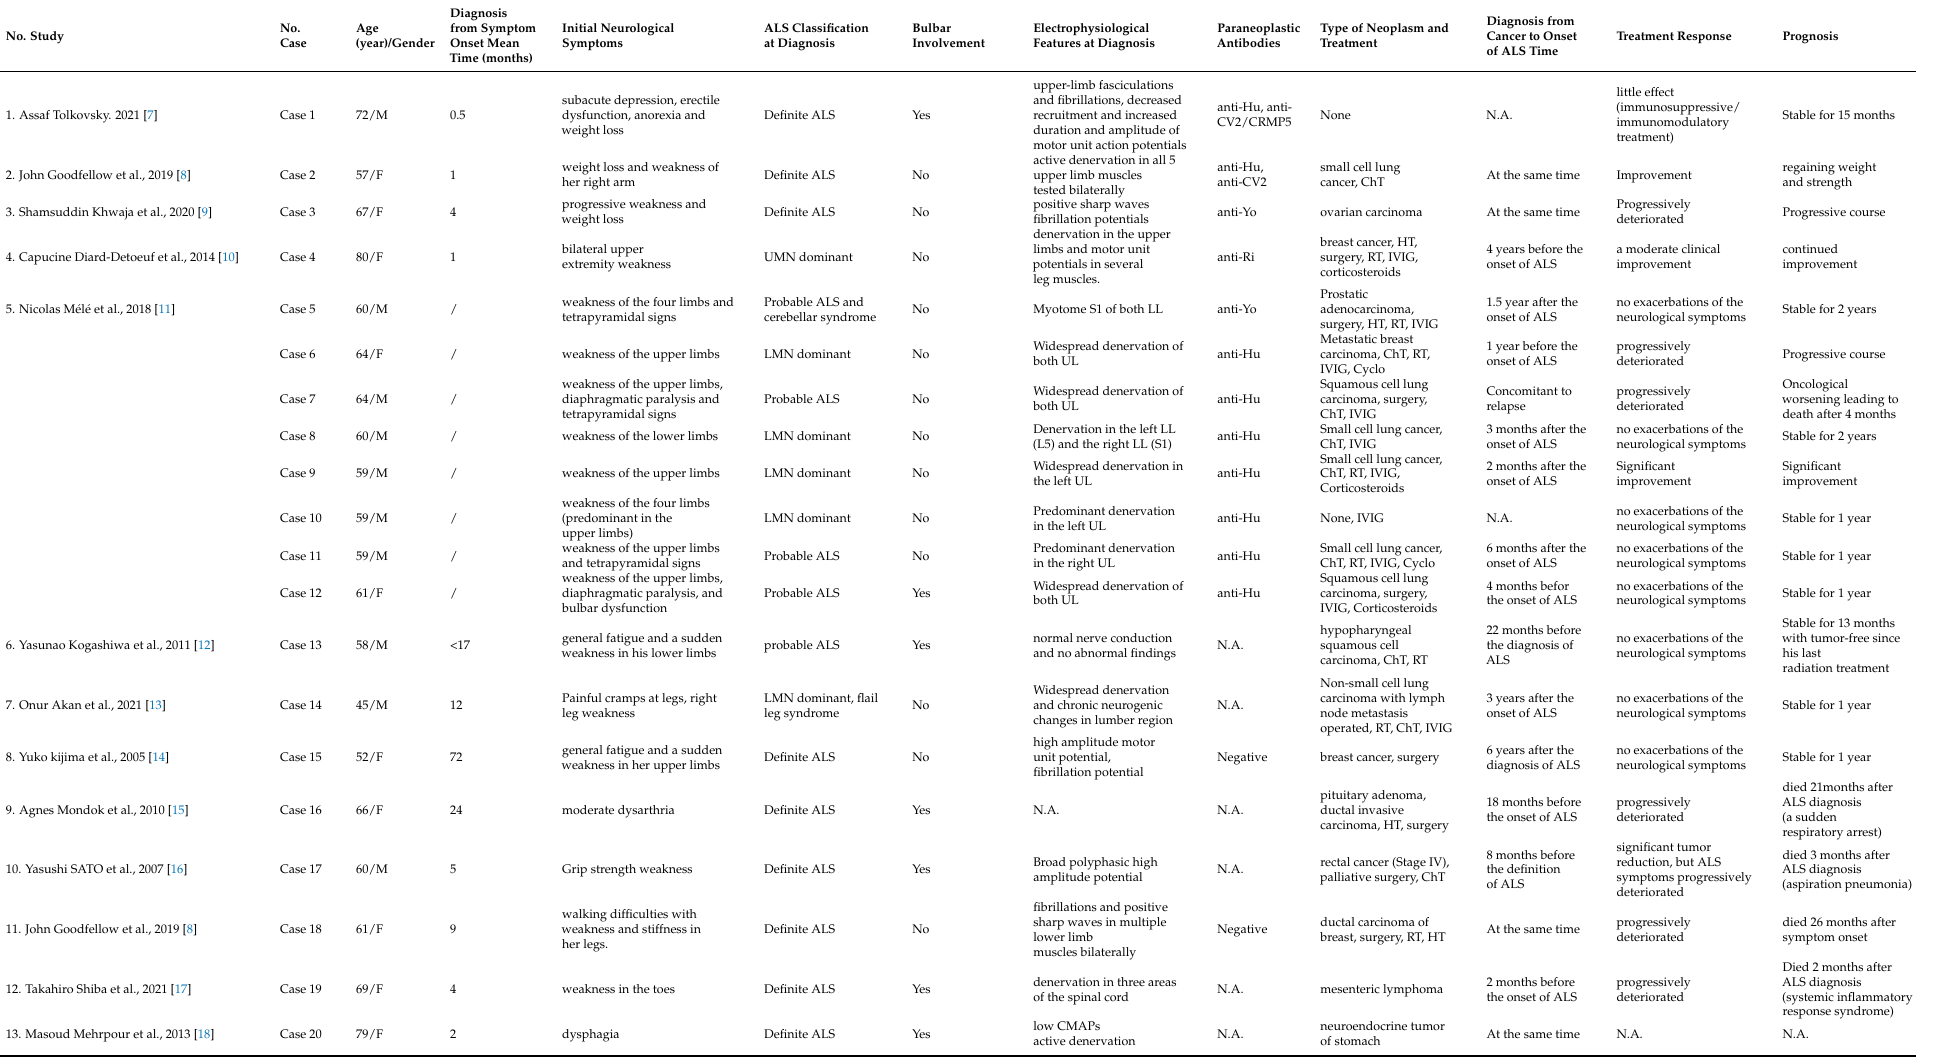
Table 1. Review of the cases of definite paraneoplastic MND and possible paraneoplastic ALS.